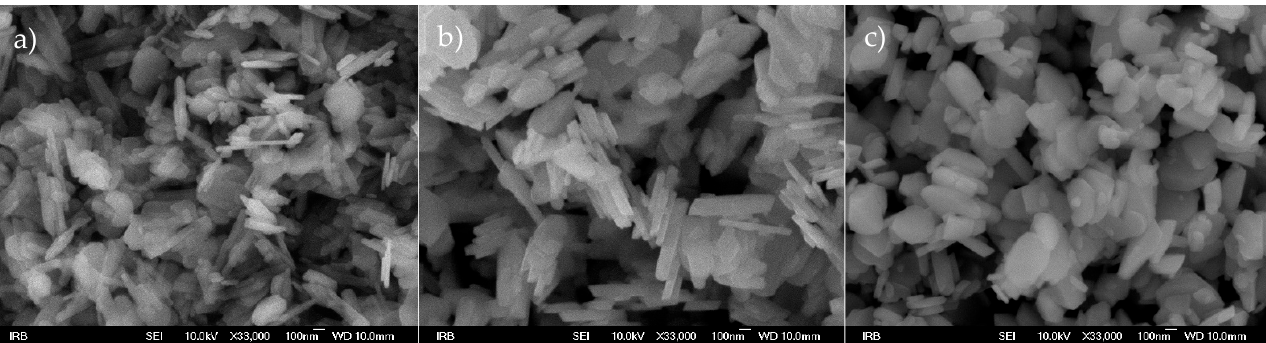
Figure 7. The FE - SEM images of ( a ) reference sample RS1, ( b ) sample S2 with 4.5% PEG, and ( c ) Figure 7. The FE-SEM images of ( a ) reference sample RS1, ( b ) sample S2 with 4.5% PEG, and sample S12 with 4.5% lavender essential oil, prepared at 200 °C for 20 min, taken at 33,000 × magni- ( c ) sample S12 with 4.5% lavender essential oil, prepared at 200 ◦ C for 20 min, taken at 33,000 × fication.